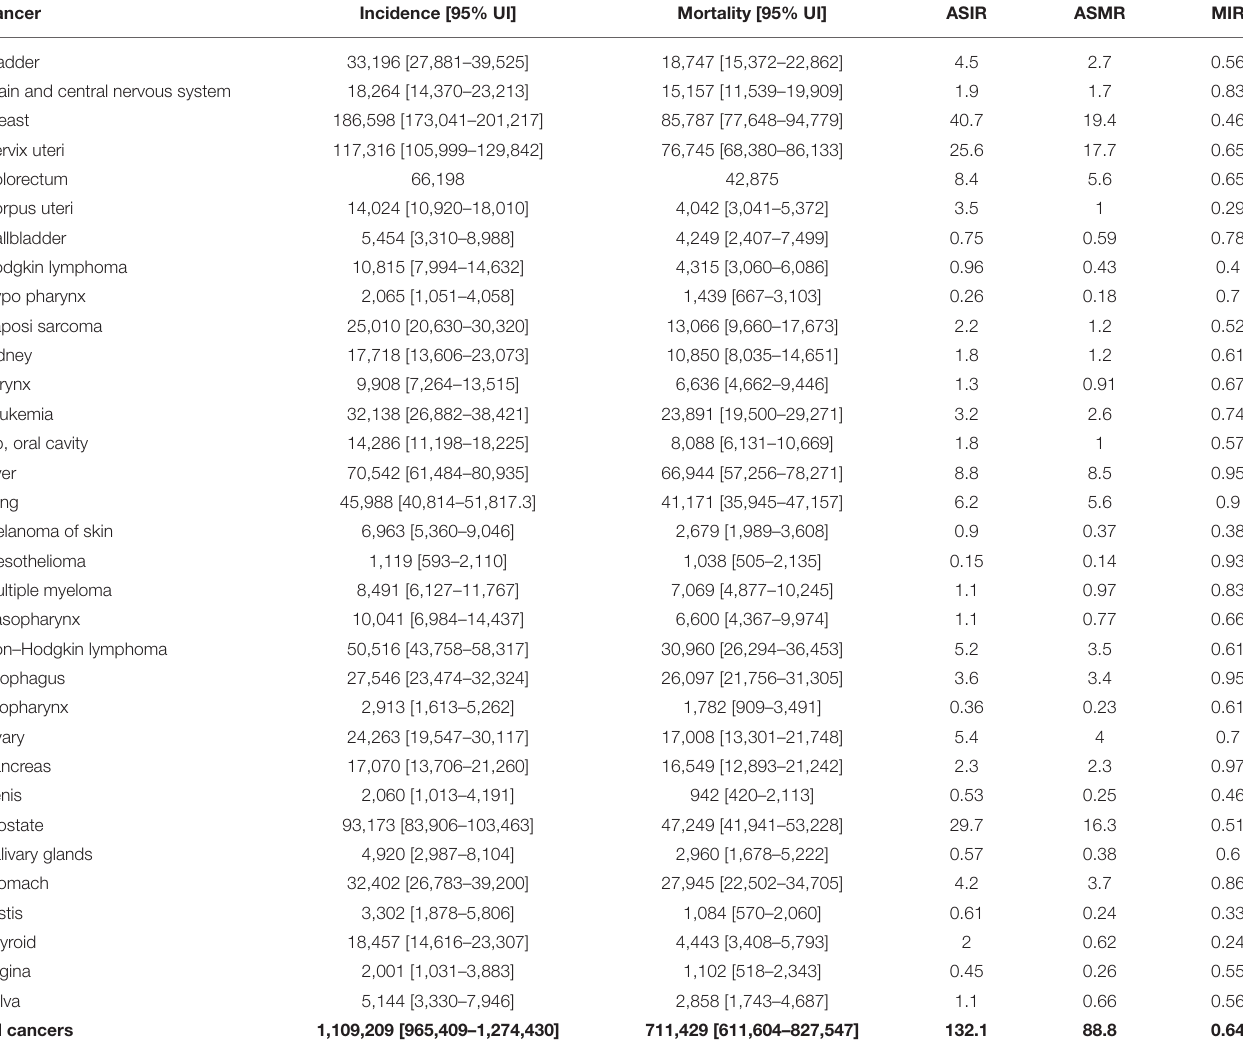
TABLE 2 | Cancer-specific burden of 34 cancer groups in Africa, 2020 (both sexes combined).